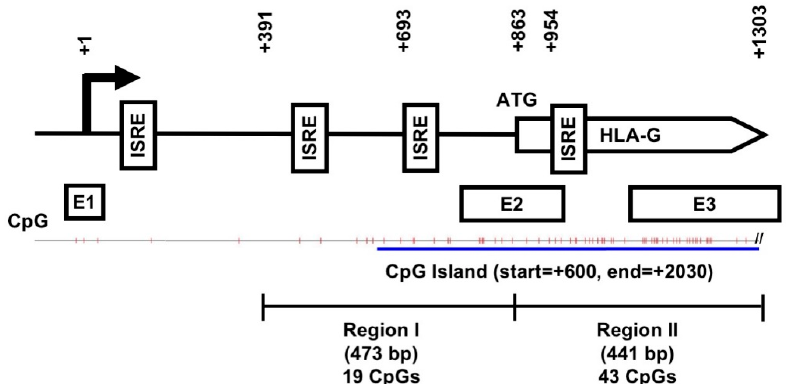
Figure 3. Schematic representation of predicted CpG site locations on the HLA-G proximal promoter and coding region. A large CpG island (blue line) extends from the promoter ( + 600) to Intron 4 of the gene body ( + 2030): Region I contains 19 CpG sites (tick marks) from + 391 to ATG ( + 863) and Region II contains 43 CpG sites from ATG to + 1303. Numbers indicated are relative to the transcription start site (TSS; + 1). Boxes represent regulator binding sites: ISRE, interferon-stimulated response element; + 1, transcription start site (TSS); ATG, translation initiation site; E, exon.